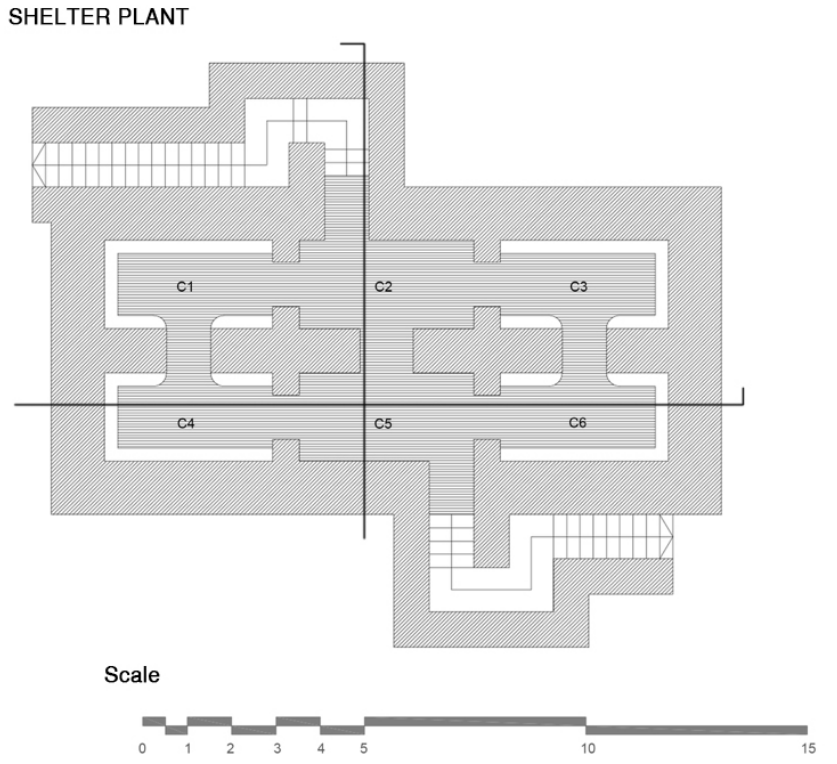
Figure 6. Plant of the refuge of Plaza Balmis with six cells connected in both directions forming two large longitudinal halls.